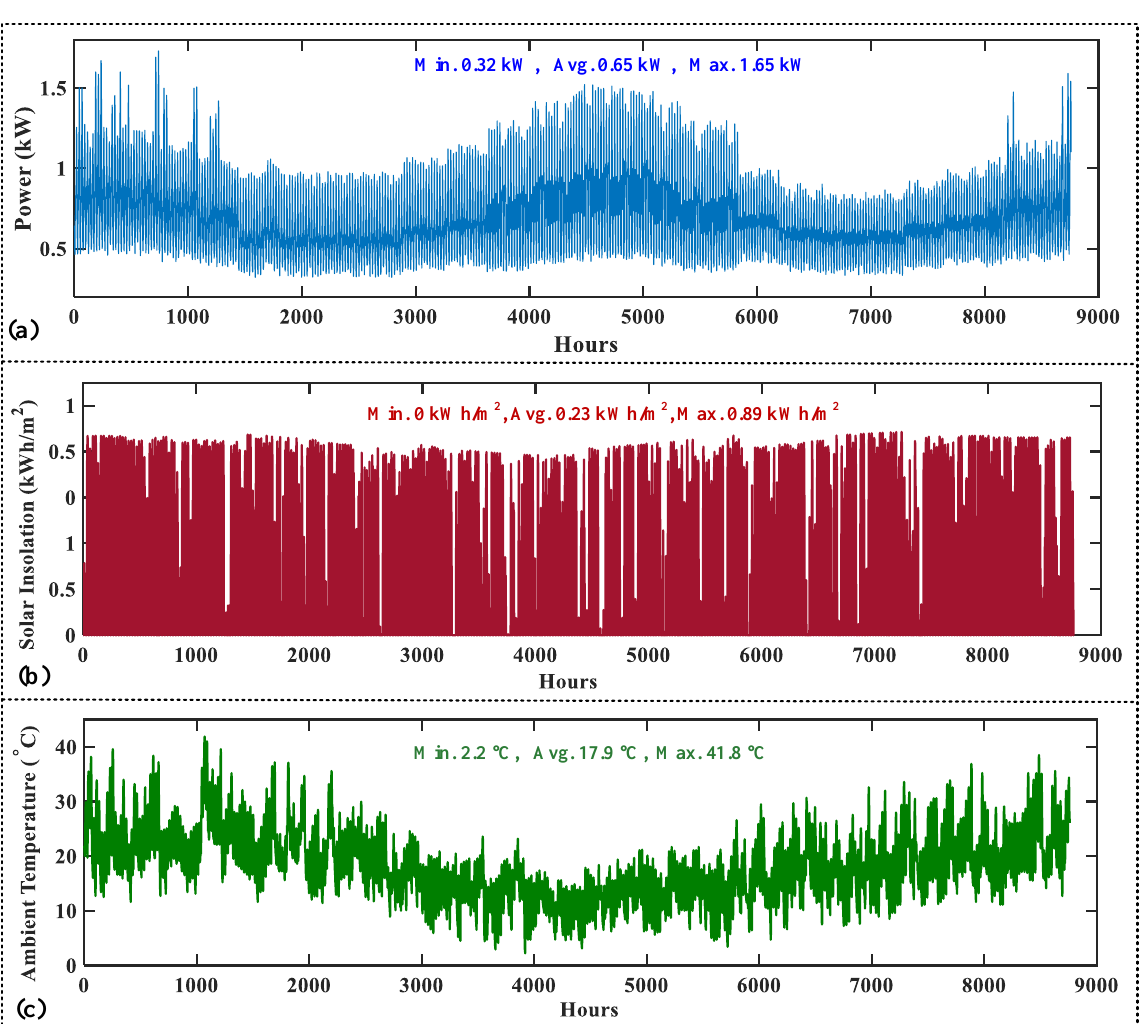
Figure 5. Annual variations of ( a ) electricity consumption, ( b ) solar insolation, and ( c ) ambient temperature.